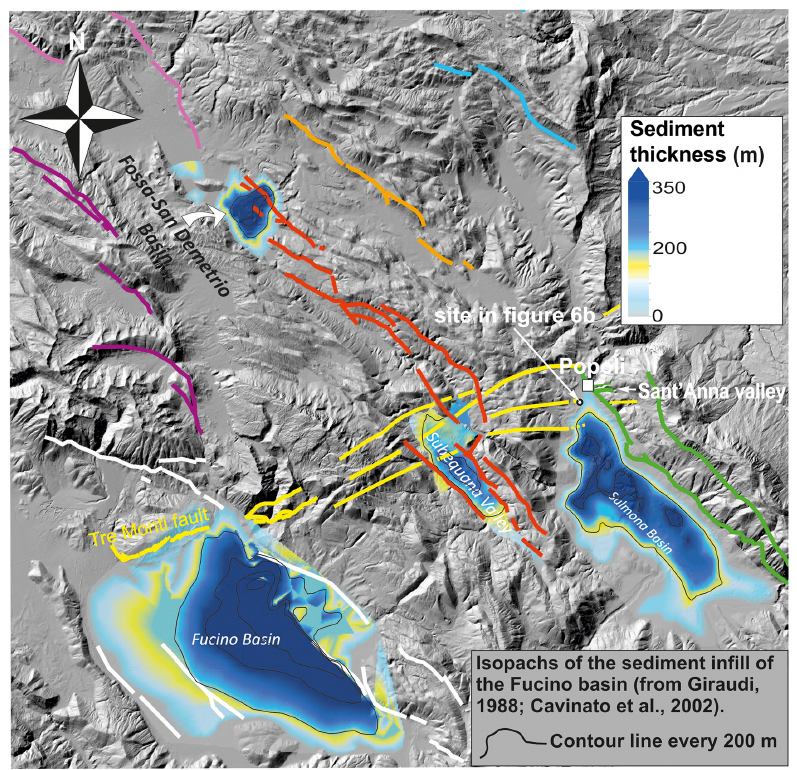
Figure 8. Shaded relief on which the reconstruction of the isopachs of the Fucino Basin, Subequana Valley, and Sulmona Basin sedimentary infill are reported, as well as that of the Fossa–San Demetrio depression, derived by crossing data from Bosi and Bertini (1970), Cesi et al. (2010), Linee Guida MZS (2010), Di Nezza et al. (2010), Di Filippo et al. (2011), Civico et al. (2015), and Pucci et al. (2016); legend of the fault systems as in Fig.